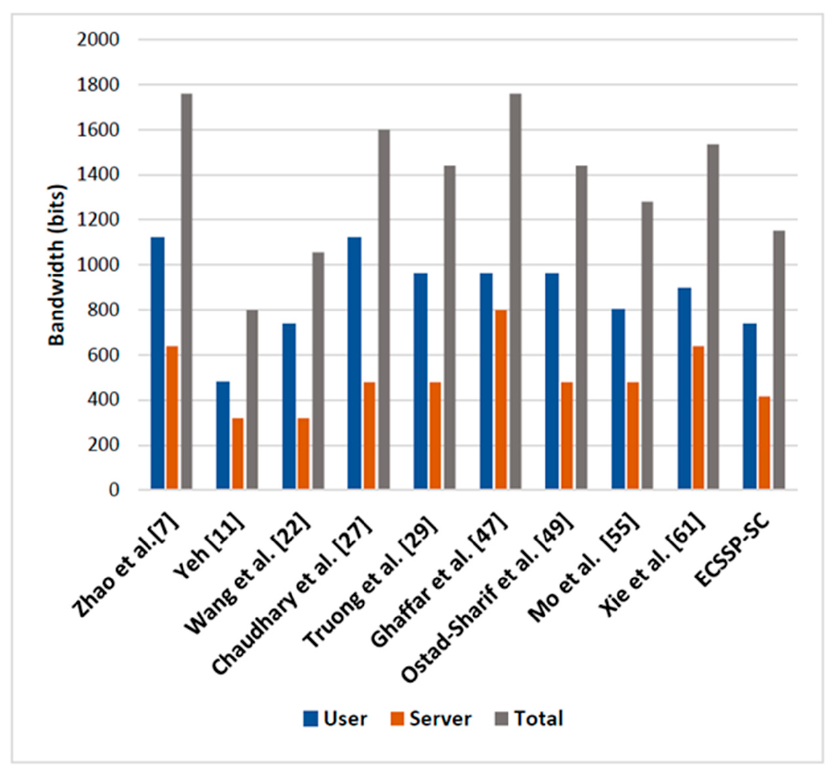
Figure 10. Comparison of the communication cost of smart card security protocols.